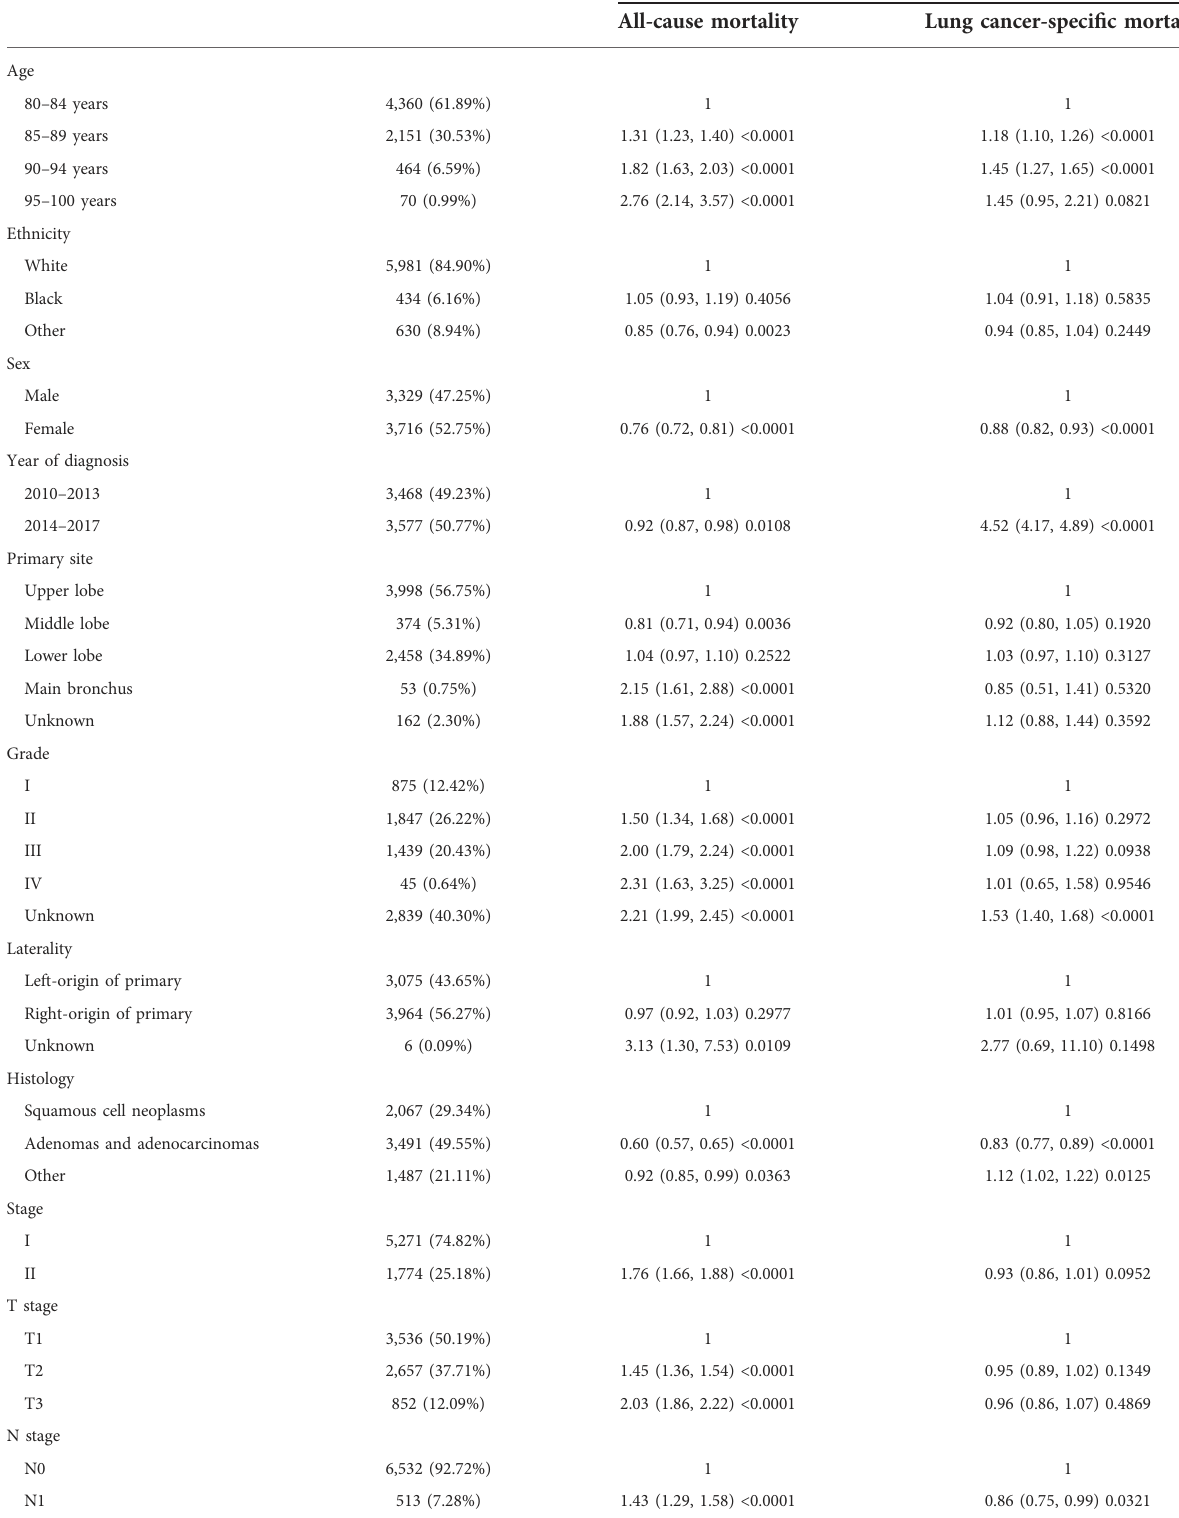
TABLE 2 Crude univariate analysis of the association between treatment method and